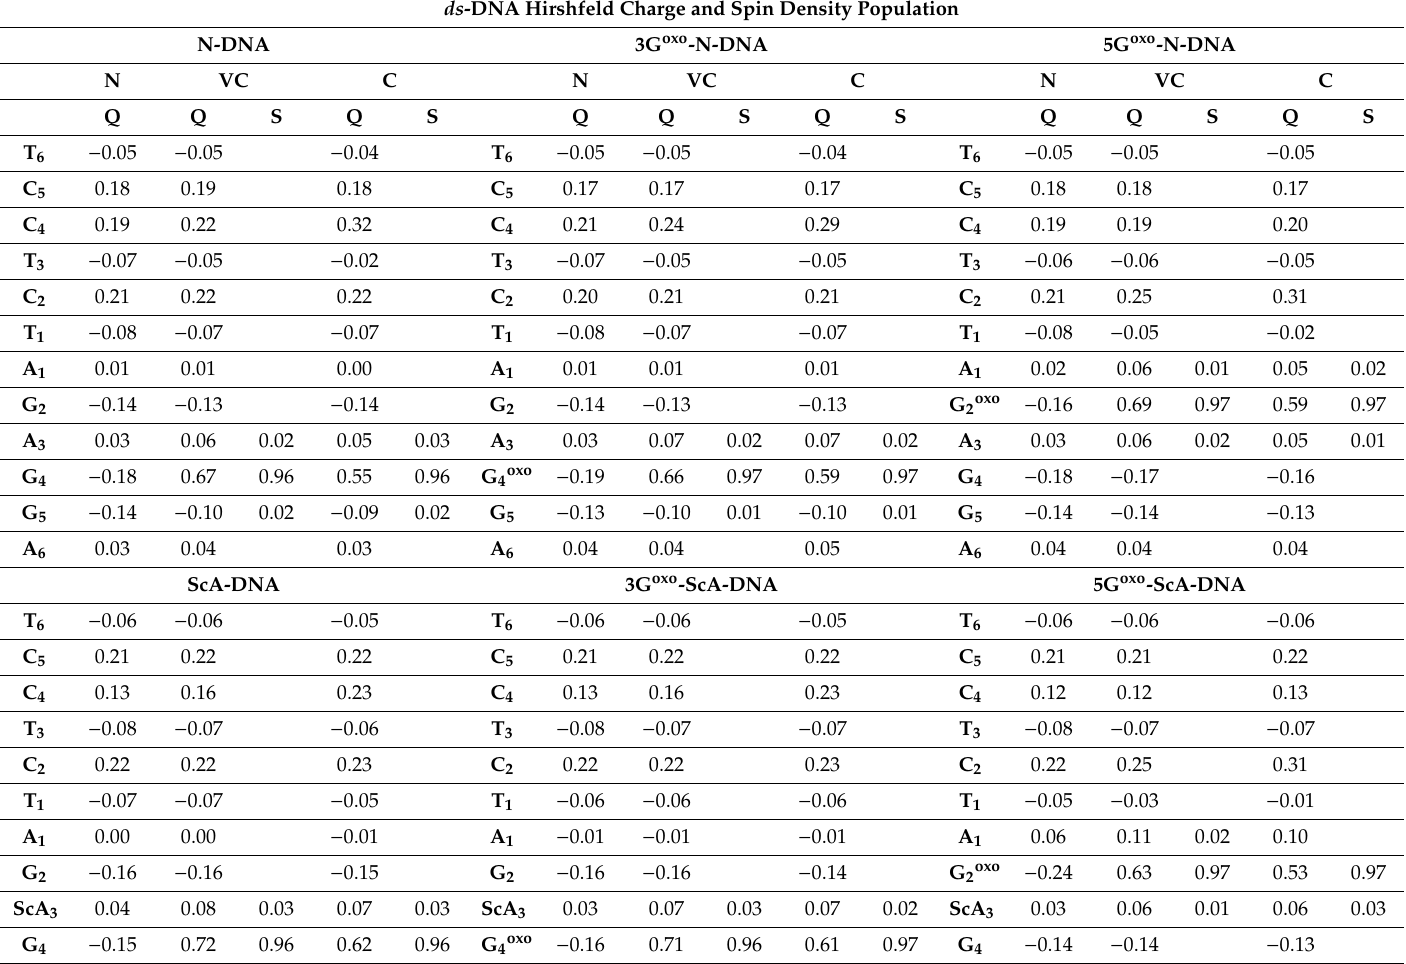
Table 8. Hirshfeld charge (Q) and spin (S) in [au] distribution in the shape of ds -oligonucleotides only nucleosides bases were taken into consideration, calculated at the M062X / D95* // M062x / 6-31 + G** level of theory in the aqueous phase. A—neutral, VC—vertical cation, C—adiabatic